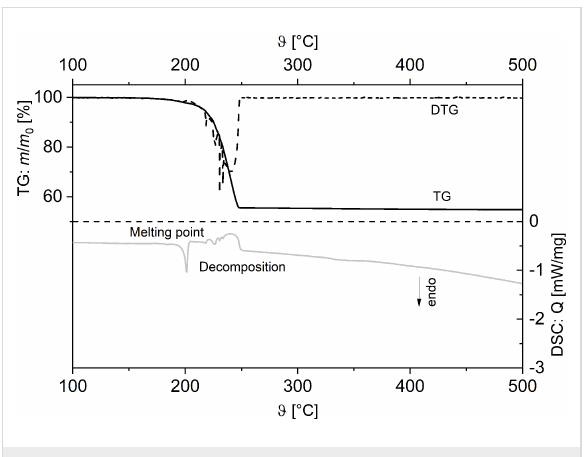
Figure 2: TG/DTG (top) and DSC (bottom) traces of 1 (Ar, gas flow 60 mL min − 1 , heating rate 10 °C min − 1 ).